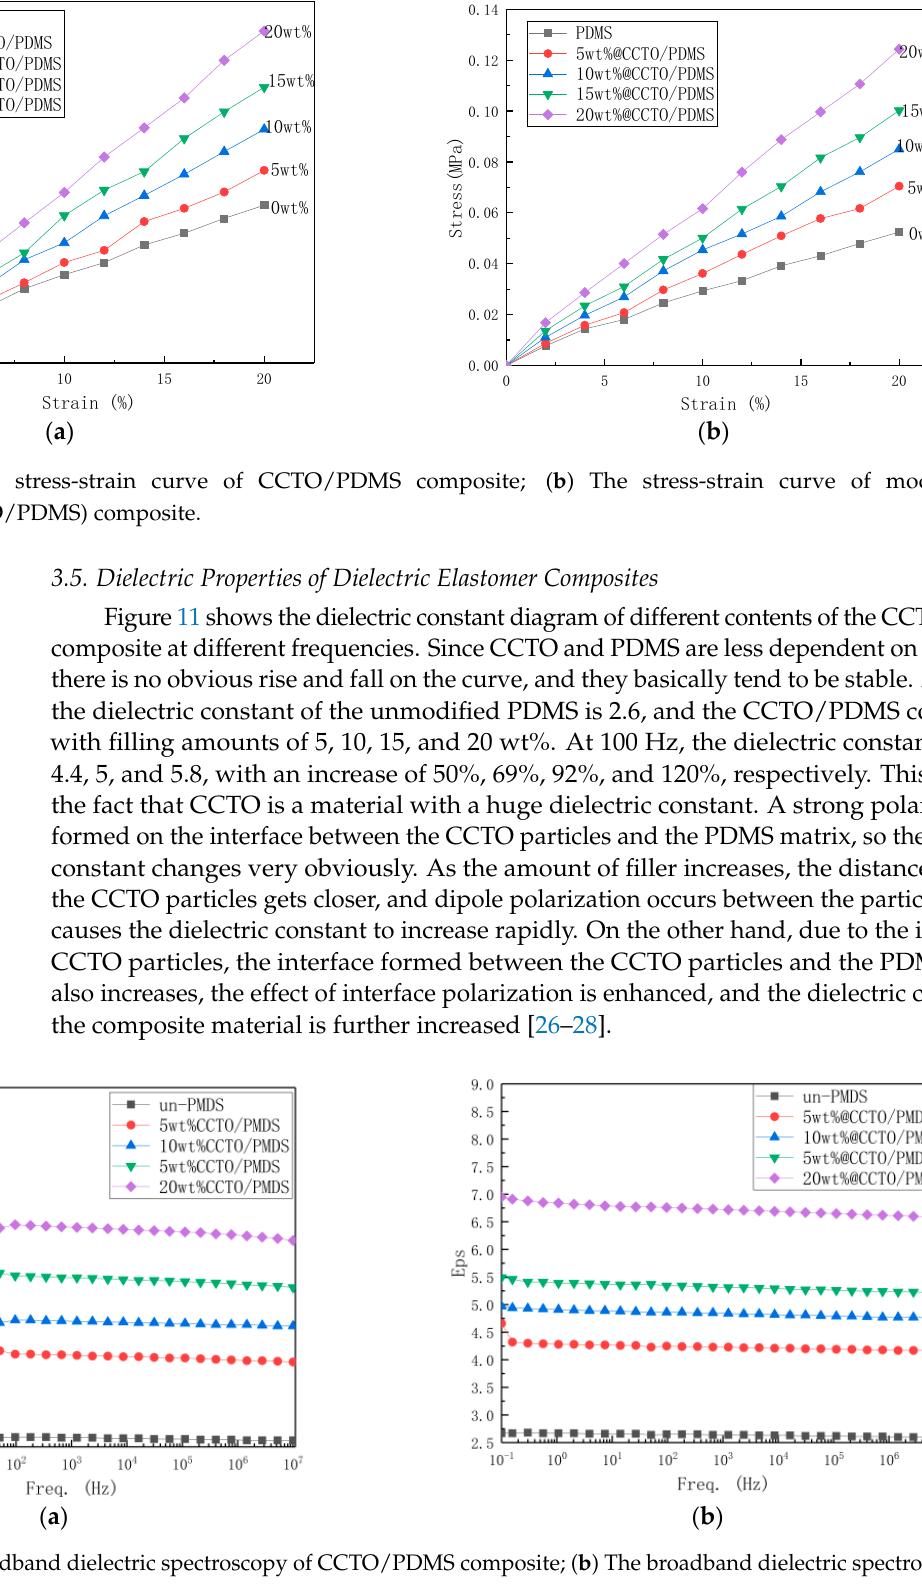
( b ) Figure 12. ( a ) The dielectric loss spectrum of CCTO/PDMS composite; ( b ) The dielectric loss spec- trum of modified CCTO/PDMS composite. As can be seen, after the KH560 modification, the dielectric loss has not increased, and is still less than 10 − 2 , maintaining a low dielectric loss. Except for the 10 wt%